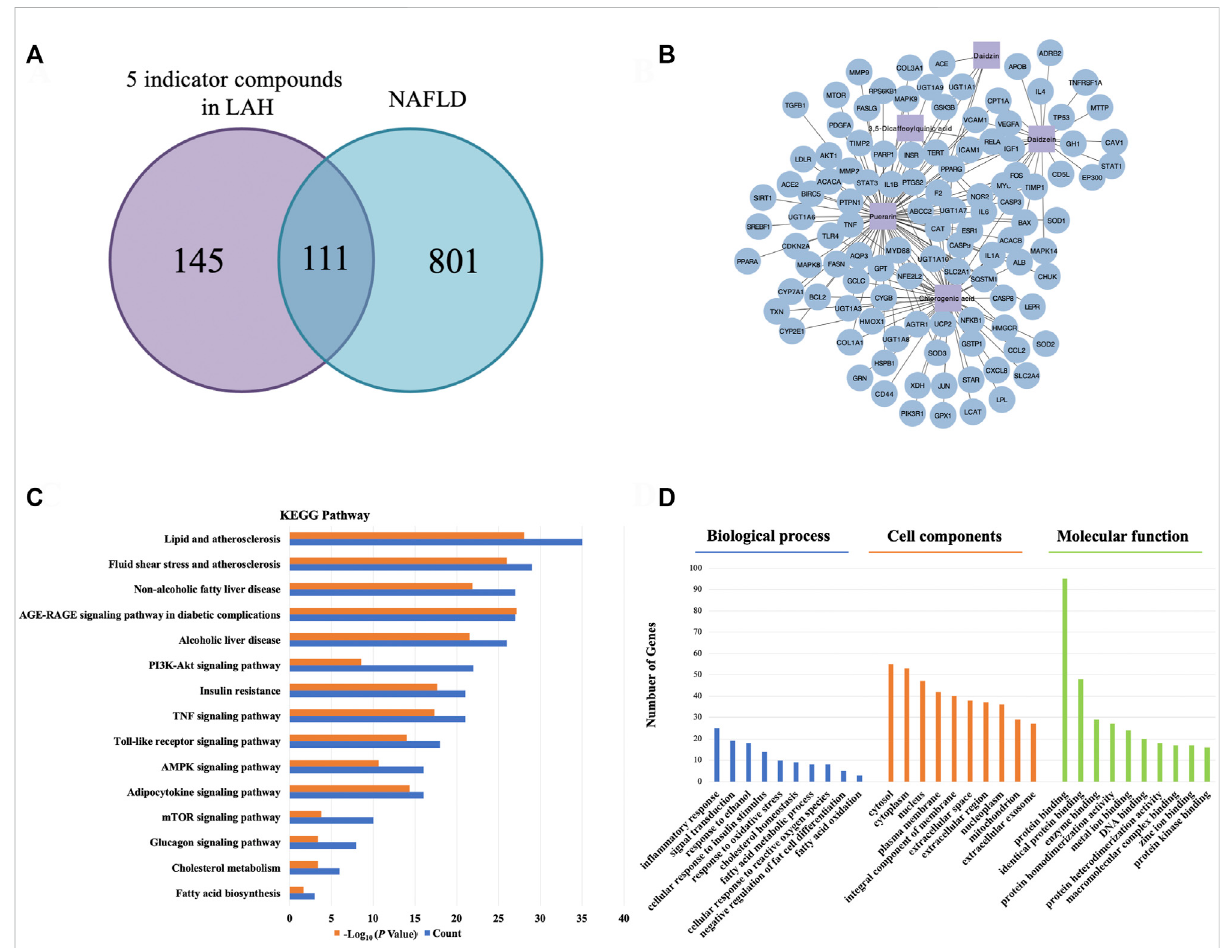
FIGURE 3 Network pharmacology analysis for LAH on NAFLD. (A) Venn diagrams of potential genes in LAH and NAFLD. (B) LAH Component-Target network. The purple square represents the 5 major components, and the blue circle represent the target genes. (C) The KEGG pathway enrichment analyses of 111 target proteins. (D) The GO enrichment analyses of 111 target